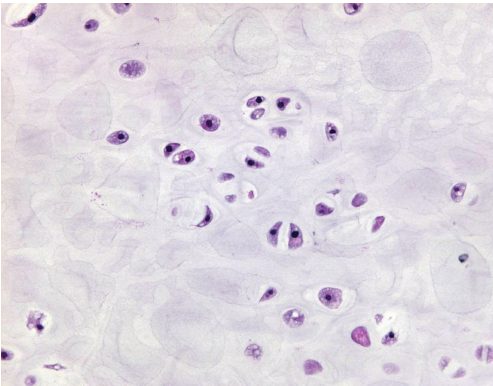
Figure 10: Grade 1 CHS arising in osteochondroma with loss of organized architecture and mild nuclear